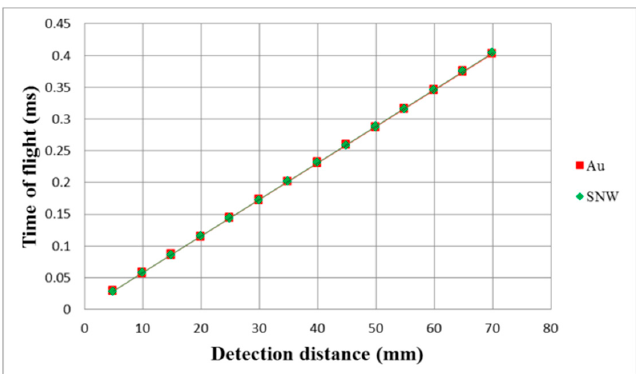
Figure 19. Detection distance relative to time of flight.